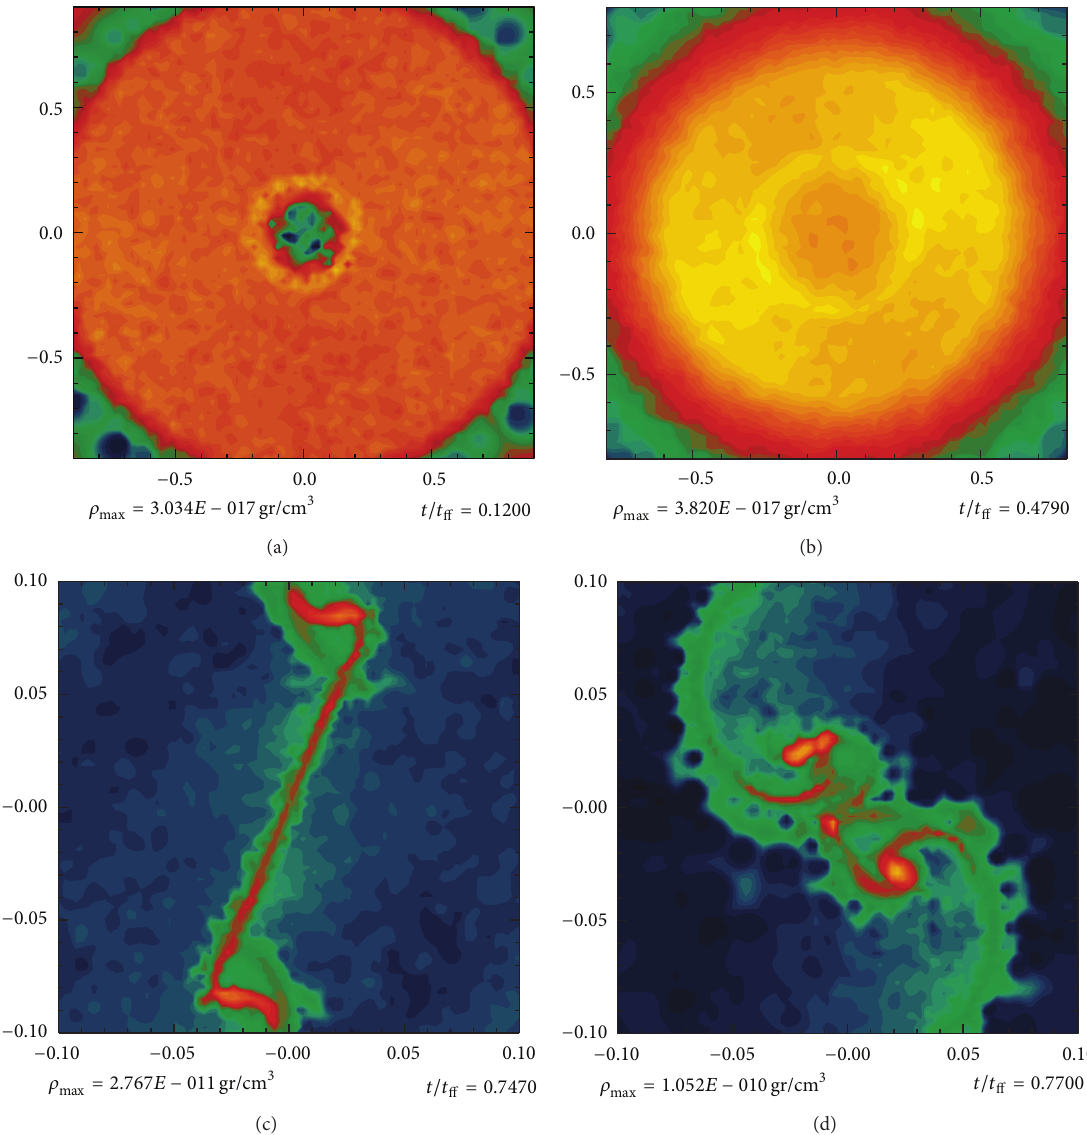
Figure 12: Iso-density plots for a thin slice of matter parallel to 𝑥𝑦 plane for the collapse of the rotating core with wind particles rotating with = 100 × Ω Ω 𝑤 𝑐